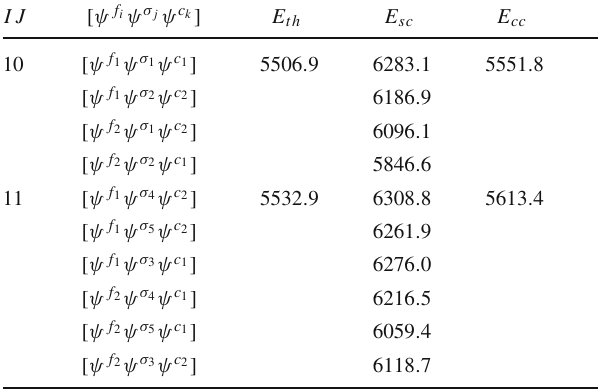
Fig. 1 The effective potentials as a function of the distance between the diquark ( qq ) and antidiquark ( ¯ q ¯ q ) for the I J = 10 and I J = 11 states of us ¯ d ¯